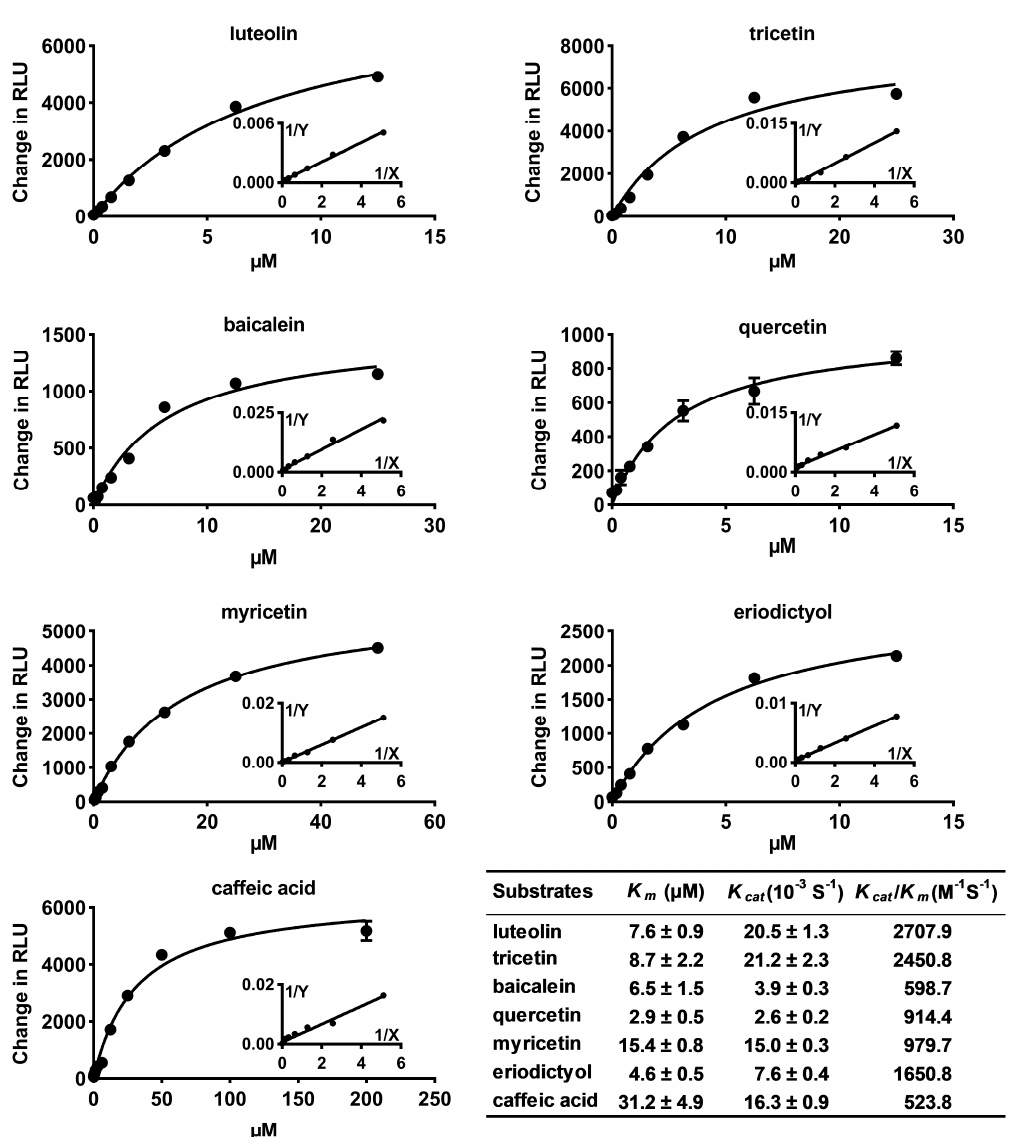
Figure 2. Kinetic analysis of Citrus reticulata O -methyltransferase 2 (CrOMT2) using seven substrates. Seven substrates with relative higher activity were selected for kinetic analysis. Apparent K m and K cat were estimated using non-linear fit to Michaelis–Menten. Change in RLU (relative light units) indicates background-subtracted RLU. The data are shown as means ± SE (n = 3).